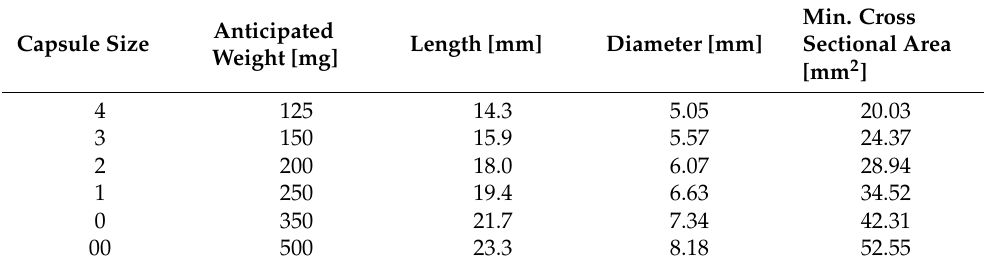
Table 2. Description of capsule characteristics. Anticipated weight was based on the weight of the capsule shells and a filling of the capsules with microcrystalline